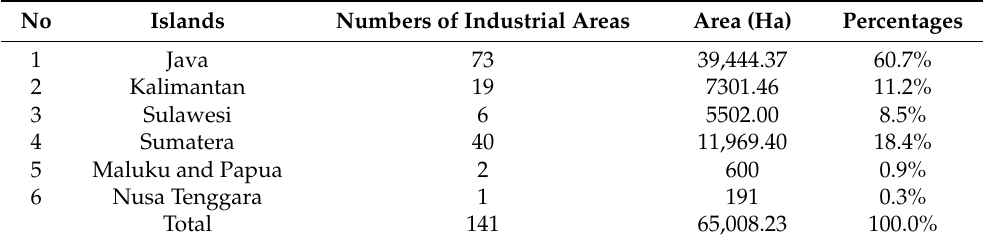
Table 2. The number of operational industrial areas in 2019 [46].